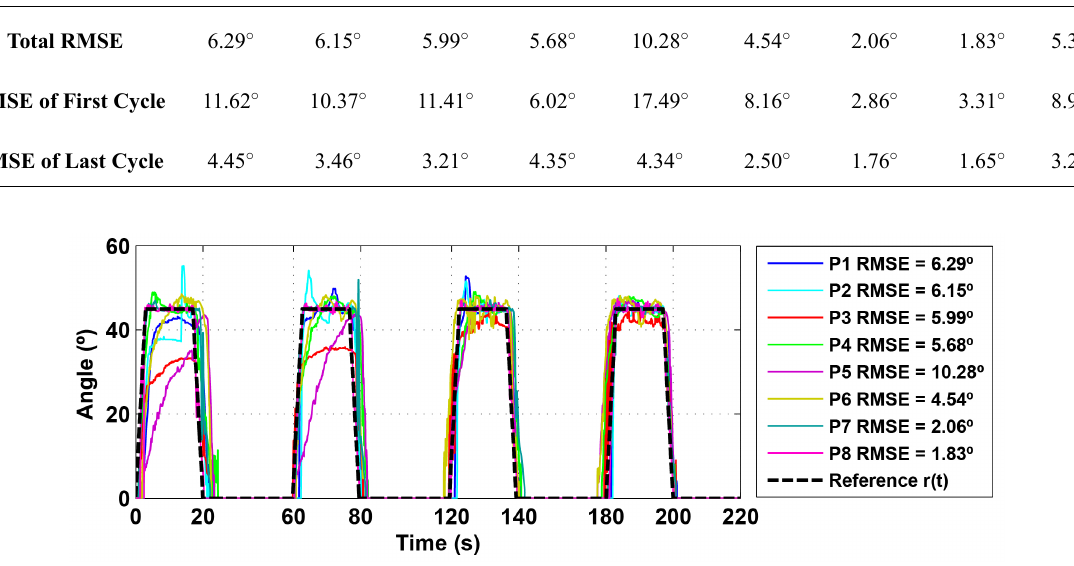
Figure 9 - Result of angular elbow joint movement with deterministic extremum seeking for eight stroke patients and their individual RMS errors. The reference signal is represented by the dashed